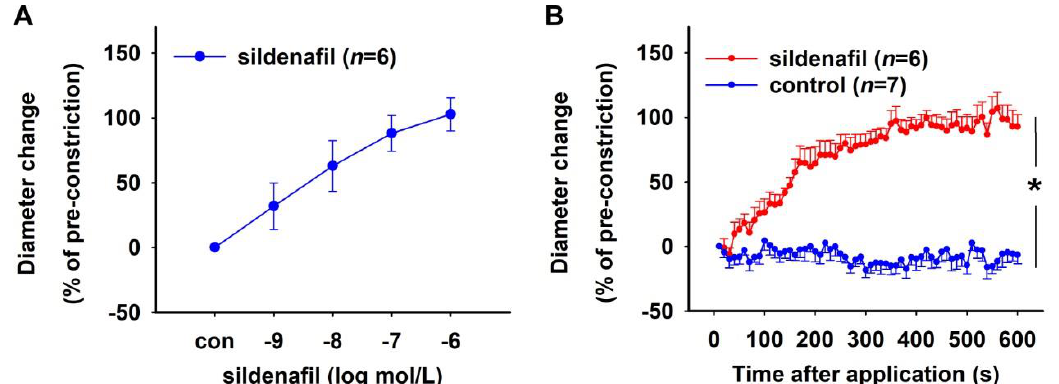
Figure 2. Effect of the PDE5 inhibitor sildenafil. Rat DVR were pre-constricted with 10 − 6 mol/L Ang II. ( A ) Concentration–response curve showing vasorelaxation induced by 10 − 9 to 10 − 6 mol/L sildenafil. Vessel diameter did not change in the absence of sildenafil (con). ( B ) Time–response curves showing relaxation induced by 10 –7 mol/L sildenafil over a period of 10 min. Sildenafil caused an almost instantaneous relaxation of the vessels with 100% relaxation achieved in 5 min (Brunner test, * p < 0.001). Control vessels without sildenafil treatment remained constricted throughout the experiment.